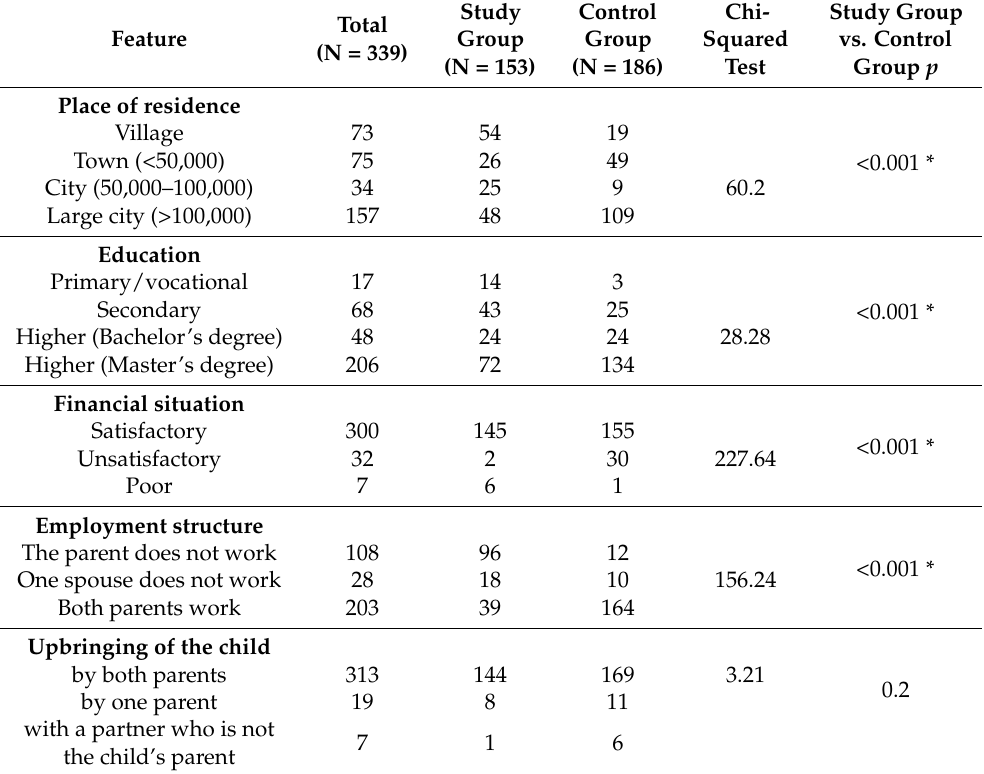
Table 1. Socio-economic characteristics of the study group and controls.